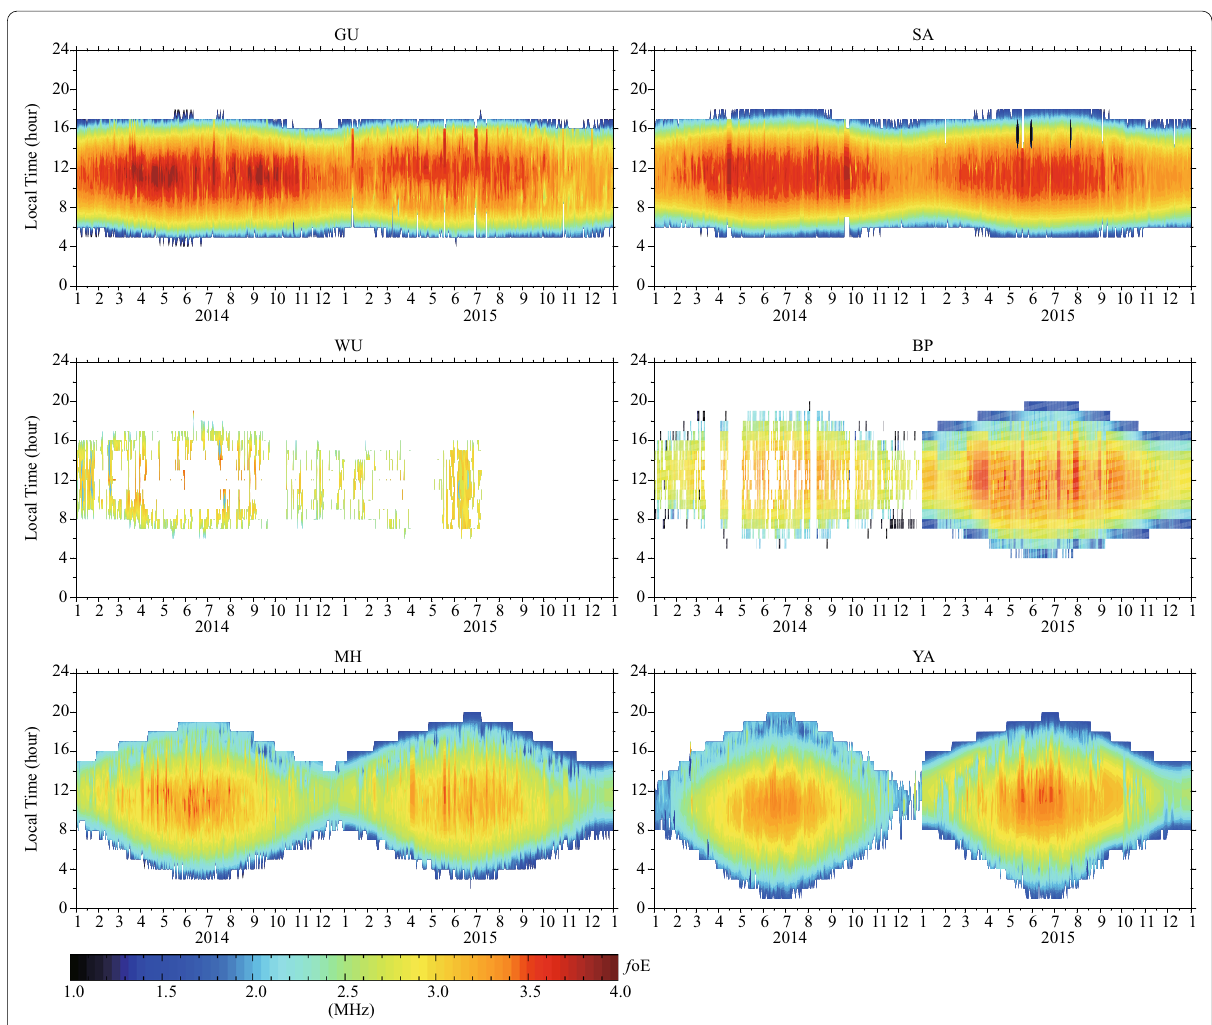
Fig. 2 Time sequences of f oE during 2014–2015 at Guam (GU), Sanya (SA), Wuhan (WU), Beijing (BP), Mohe (MH) and Yakusk